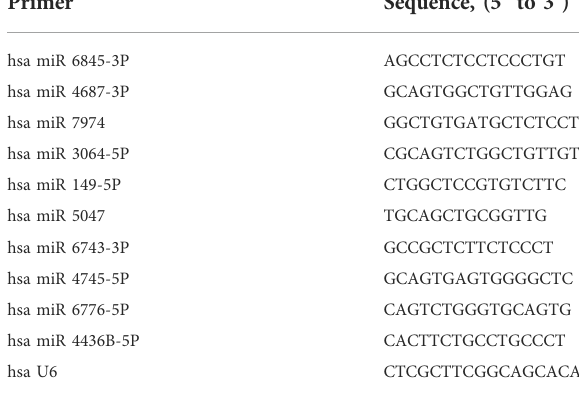
TABLE 2 Primer information table for fl uorescent quantitative miRNA detection. Primer Sequence, (5 9 to 3 9